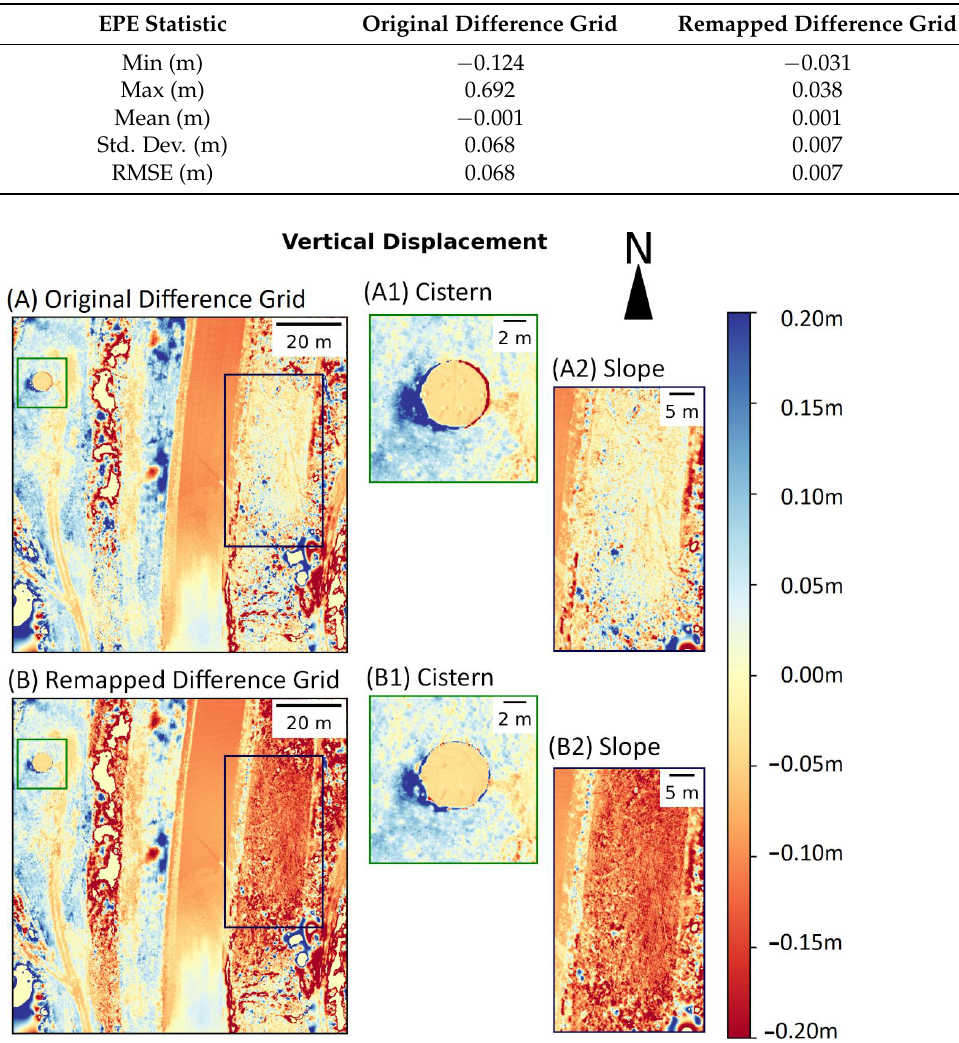
Figure 7. Vertical difference grid between DEMs from subsequent survey epochs from ( A ) a regular difference grid and ( B ) computed using the proposed remapping approach with close-up views of the cistern (#1) and hillslope (#2).